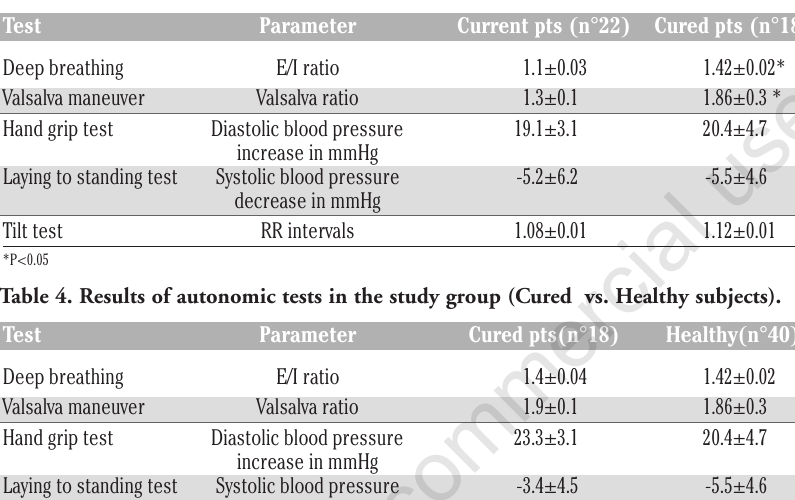
Table 3. Results of autonomic tests in the study groups (Current patients vs Healthy sub- jects).